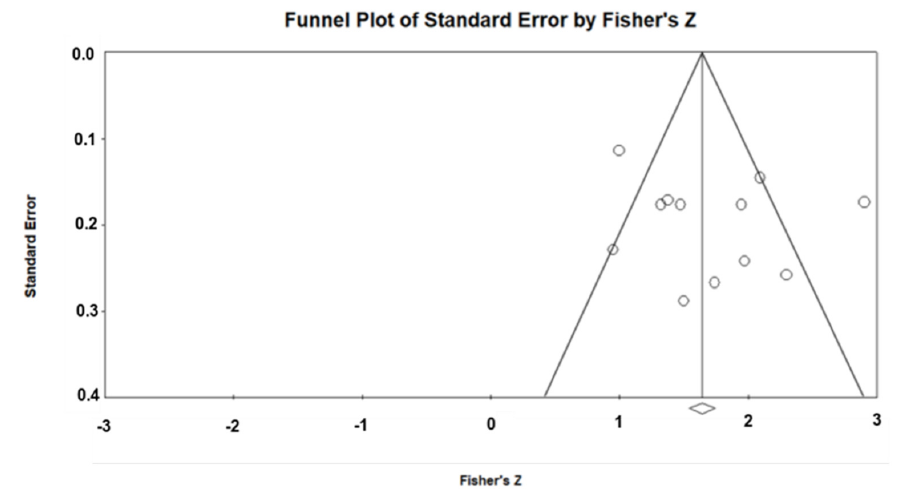
Figure 3. Funnel Plot of Standard Error.